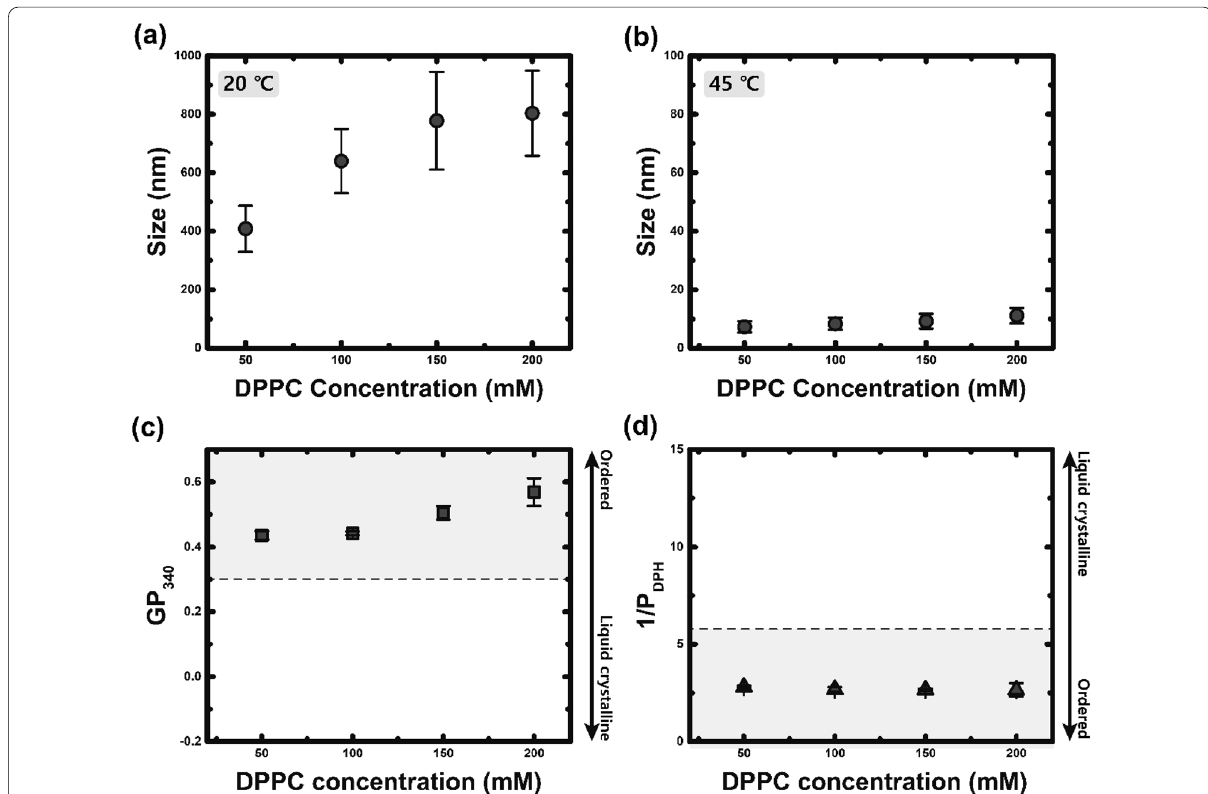
Fig. 5 Size of the assemblies synthesized at a 20 °C and b 45 °C. c Membrane polarity and (d) fluidity of the assemblies synthesized at 45 °C. All samples were prepared with fixed DHPC concentration ([DHPC] 20 mM). The values and error bar indicate the mean values and standard = deviation of measured data, respectively. The borderline of the membrane rigidity was adjusted, based on the membrane properties of